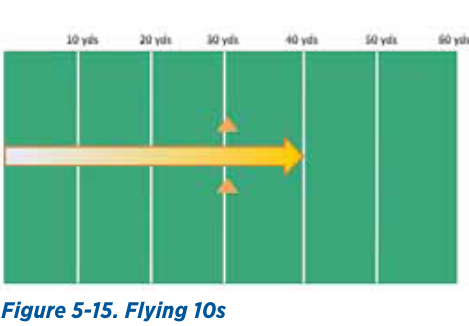
Figure 5-15. Flying 10s